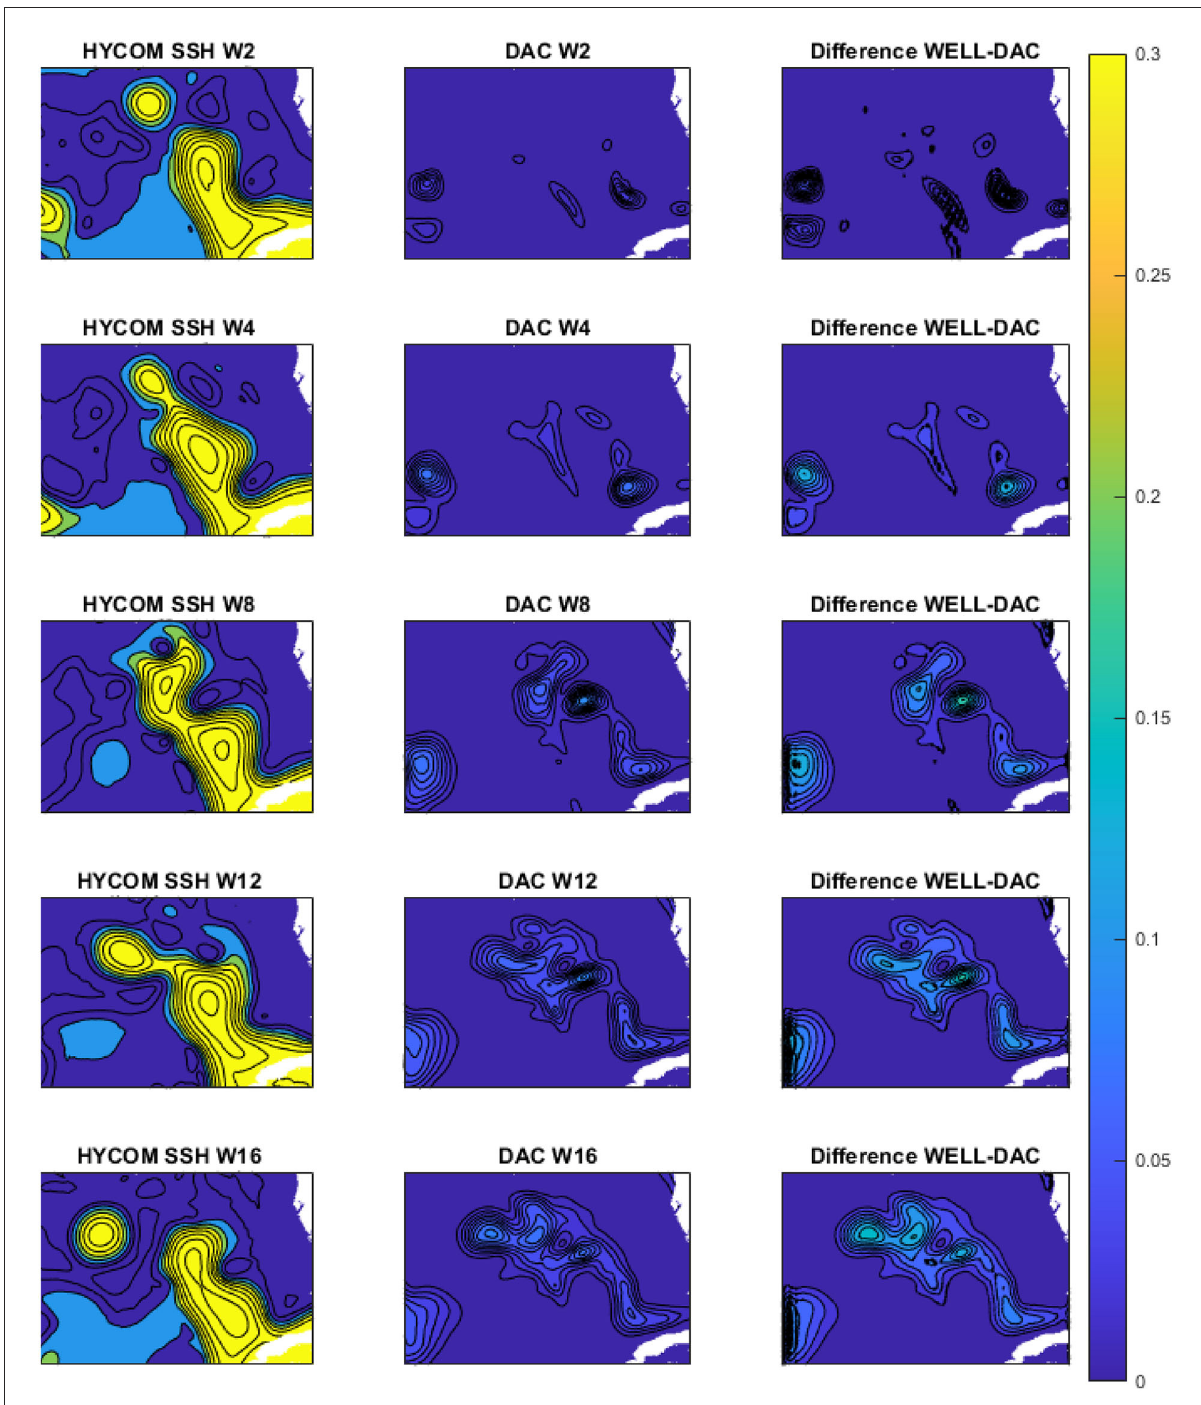
FIGURE5 Seas surface height (m) and variance ( m 2 ) over the period November 1992 to March 1993, which is part of the training period. The left column shows the HYCOM SSH; the middle column shows the variance of the DAC model SSH; the right column shows the difference in variance between the WELL 3-level compressed SSH and the DAC model SSH. W2 - W16 indicates the number of weeks starting on the first week of November